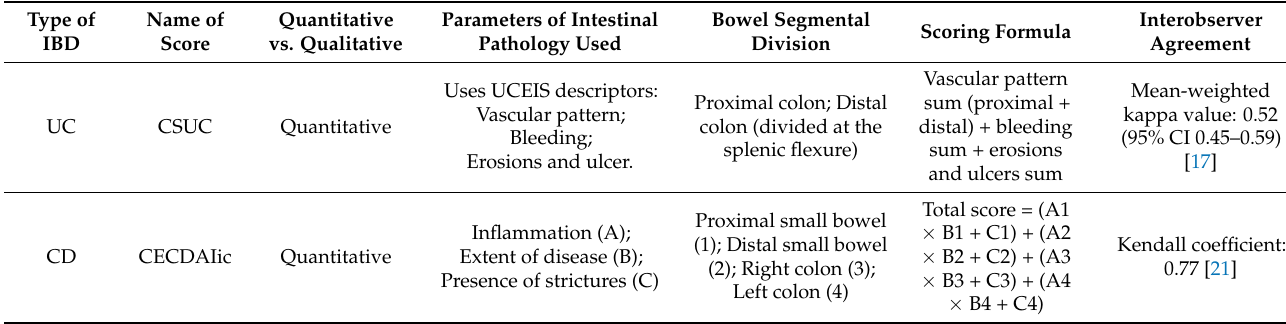
Table 7. Summary of CCE scores used in